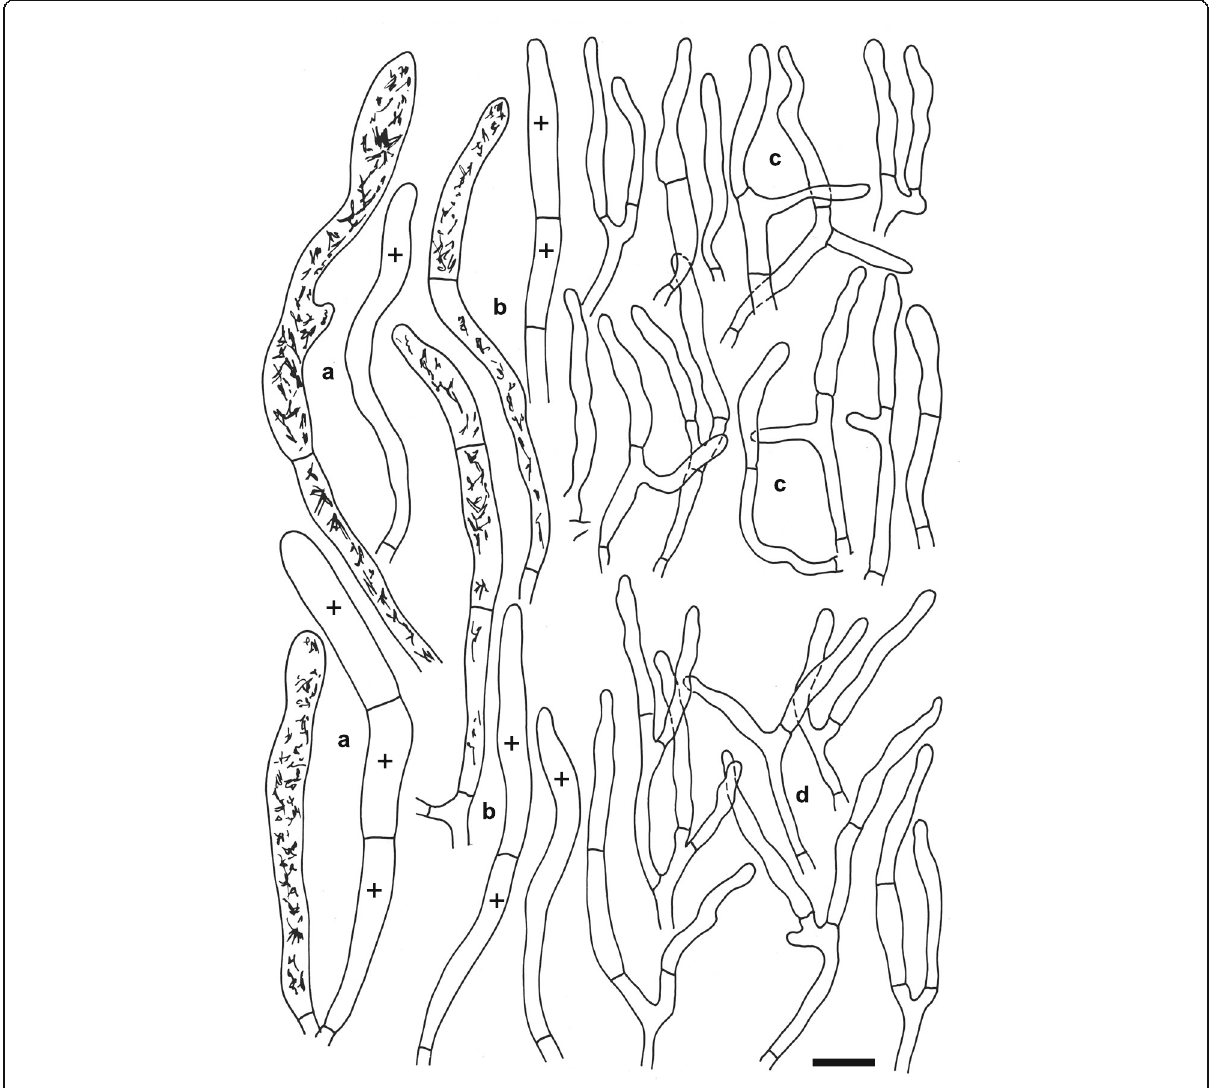
Fig. 6 Russula tengii (HMAS262728, holotype). Microscopic features of the pileipellis. a. Pileocystidia near the pileus centre. b. Pileocystidia near the pileus margin. c. Hyphal terminations in the pileus centre. d. Hyphal terminations near the pileus margin. Contents of cystidia are represented as observed in Congo red. Bars = 10 μ m. Drawings: S.A. &